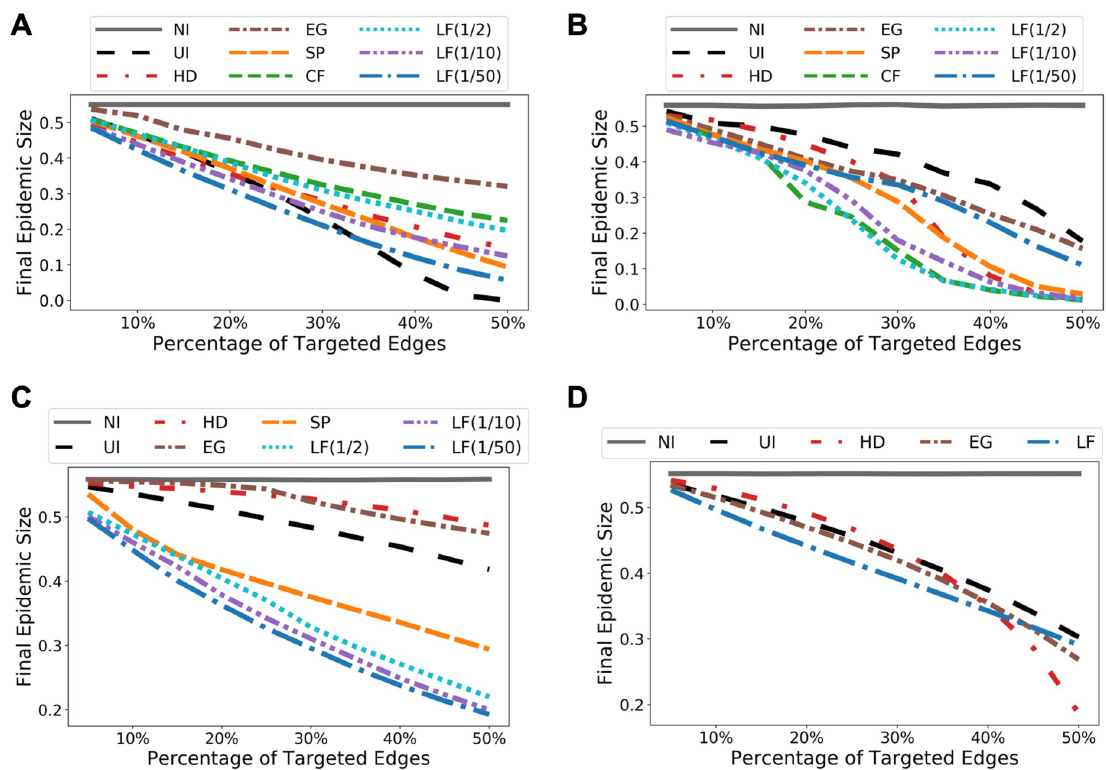
Fig 10. Simulation results under alternative model parametrization. The transmission rate parameter is calibrated so that 55% of the population would be affected without intervention. We initialized both population-based and individual-based models using random initialization, where a few randomly selected nodes are labelled as infectious at time 0. The plots show for each dataset the final epidemic sizes under different intervention strategies and various percentage coverages. We average over 50 runs for random initialization. (A) Results for Facebook County. LF for λ 2 {1/10, 1/50} still leads to the most reduction in epidemic sizes when the coverage level is less than 30%. When targeting more than 30% edges, uniform intervention (UI), which uniformly reduces the transmission rate over all edges, becomes more effective for Facebook County. This is because the transmission rate parameter is getting close to a threshold under which a pandemic would not emerge, which is seen in the 0% final size under UI at 50% coverage level. (B) Results for Wi-Fi Montreal. LF interventions still lead to the most reduction in the final sizes. (C) Results for Port. Sub. CF and LF with λ = 1/2 have the best performance overall, while LF with λ = 1/10 is the most effective when targeting less than 15% edges. (D) Results for Portland. We used λ = 1/1000 in order to scalably compute LF. We see that LF has better performance when targeting no more than 40% of all